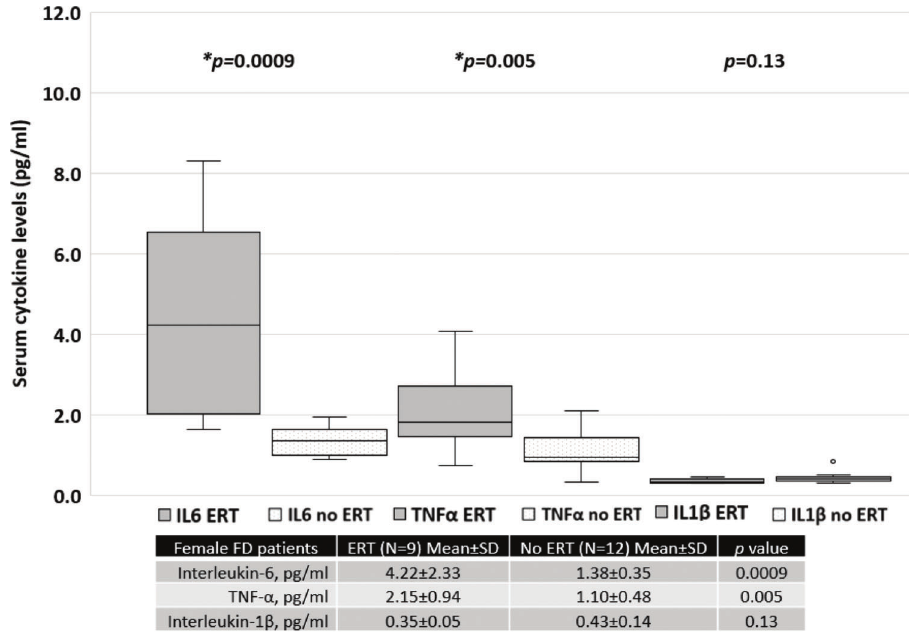
Figure S1 - Serum cytokine levels in women with FD treated with ERT versus those not treated with ERT.